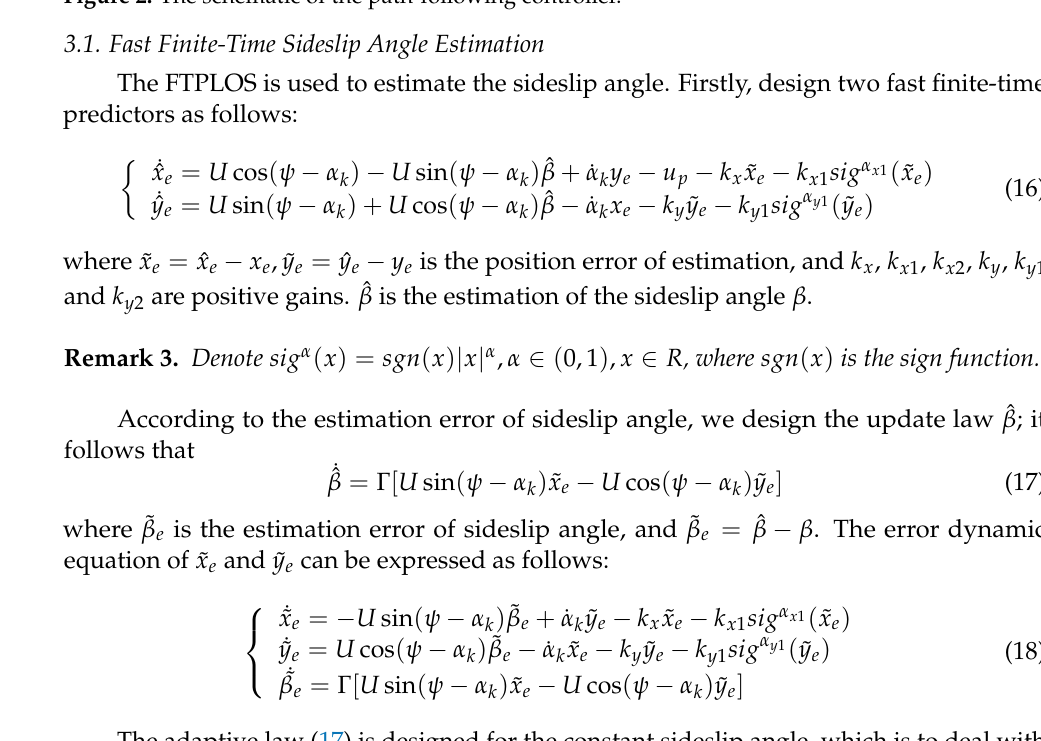
Figure 2. The schematic of the path-following